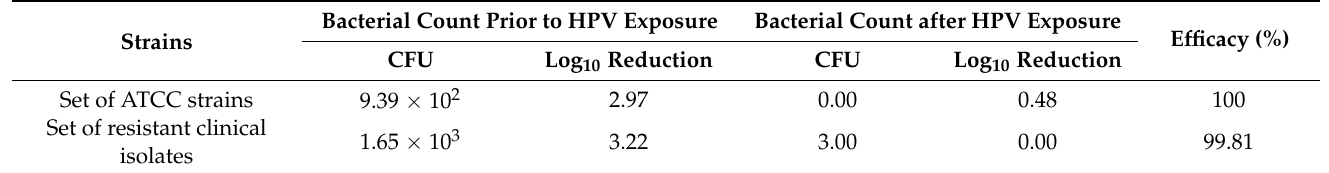
Table 4. In vitro efficacy of 8% VHP combined with 30 mg/L silver ions against sets of ATCC strains and clinical isolates on